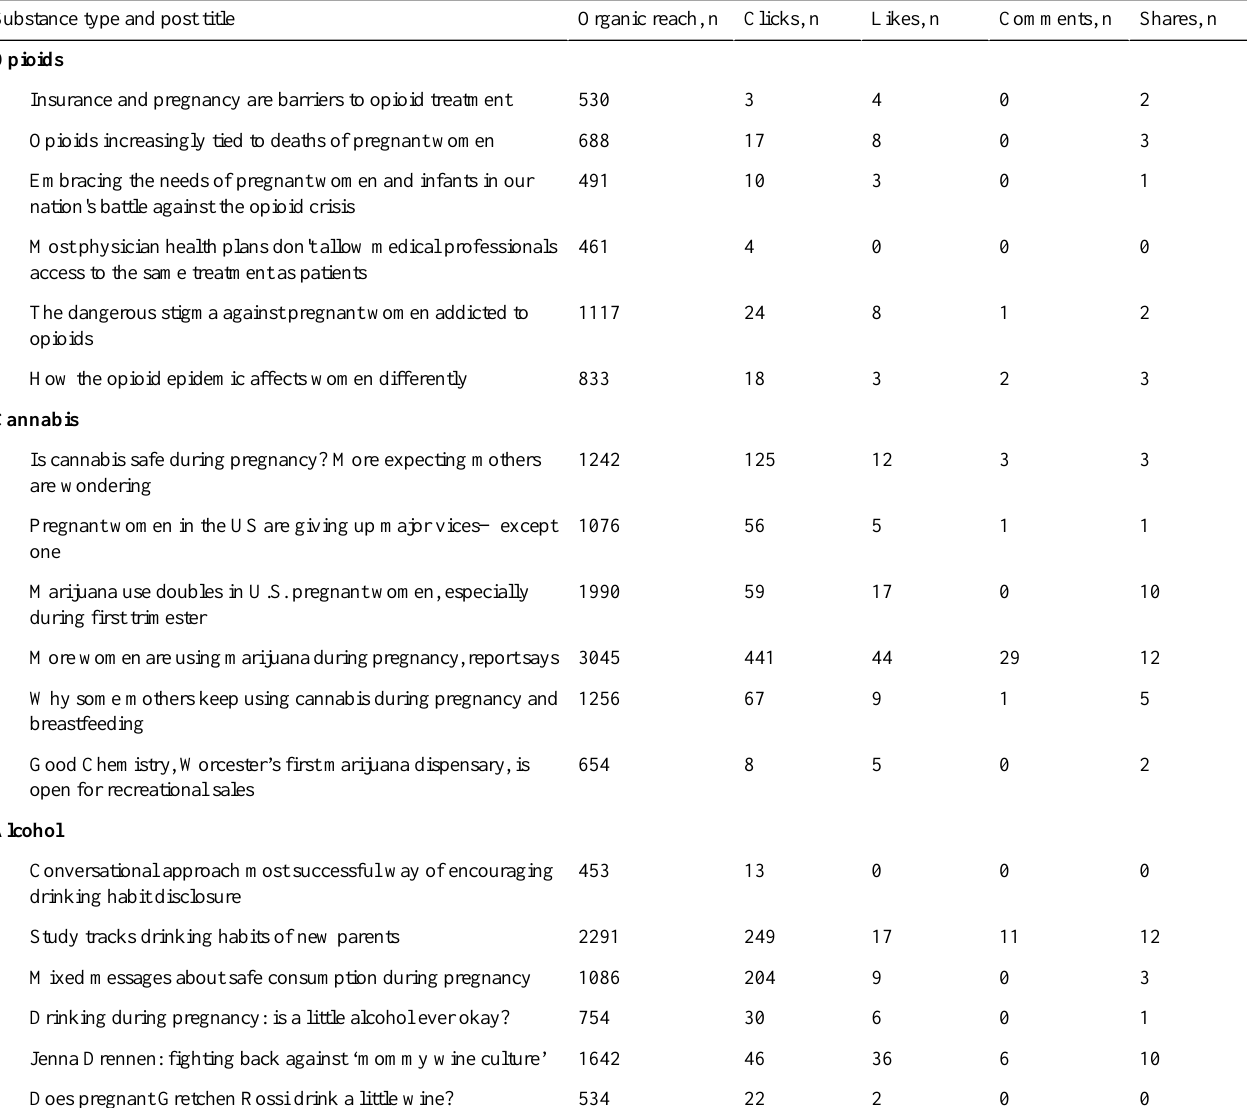
Table 2. Levels of reach and engagement per Facebook post classified by